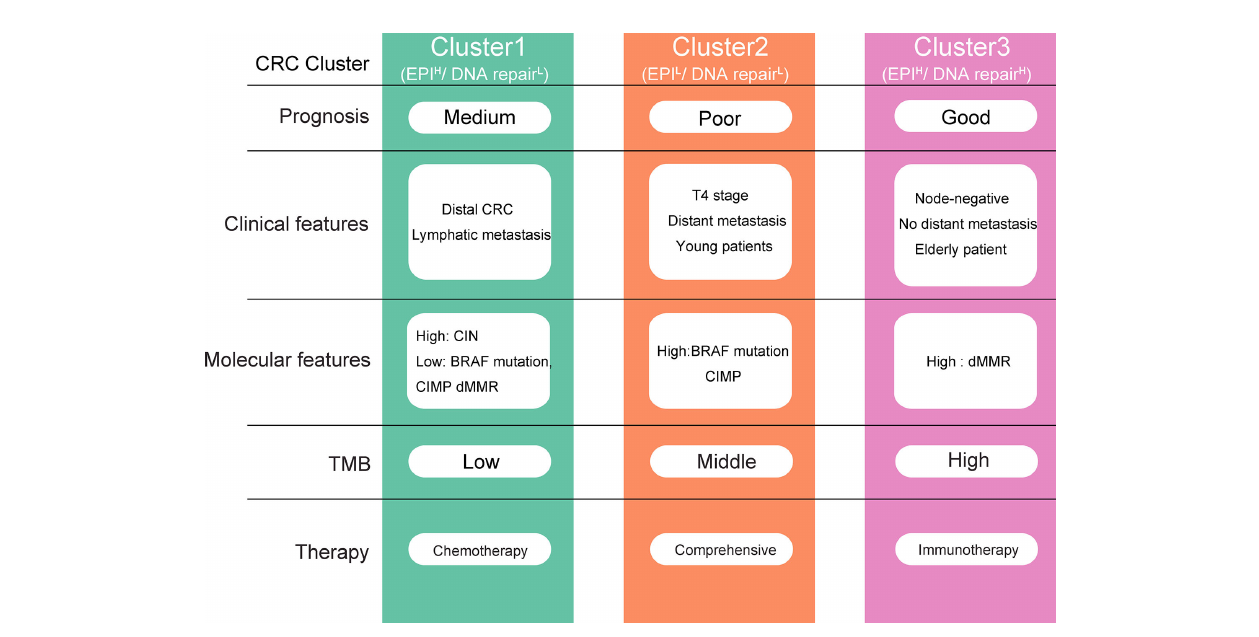
FIGURE 7 | Overview of the characteristics of three colorectal cancer (CRC) clusters. EPI,